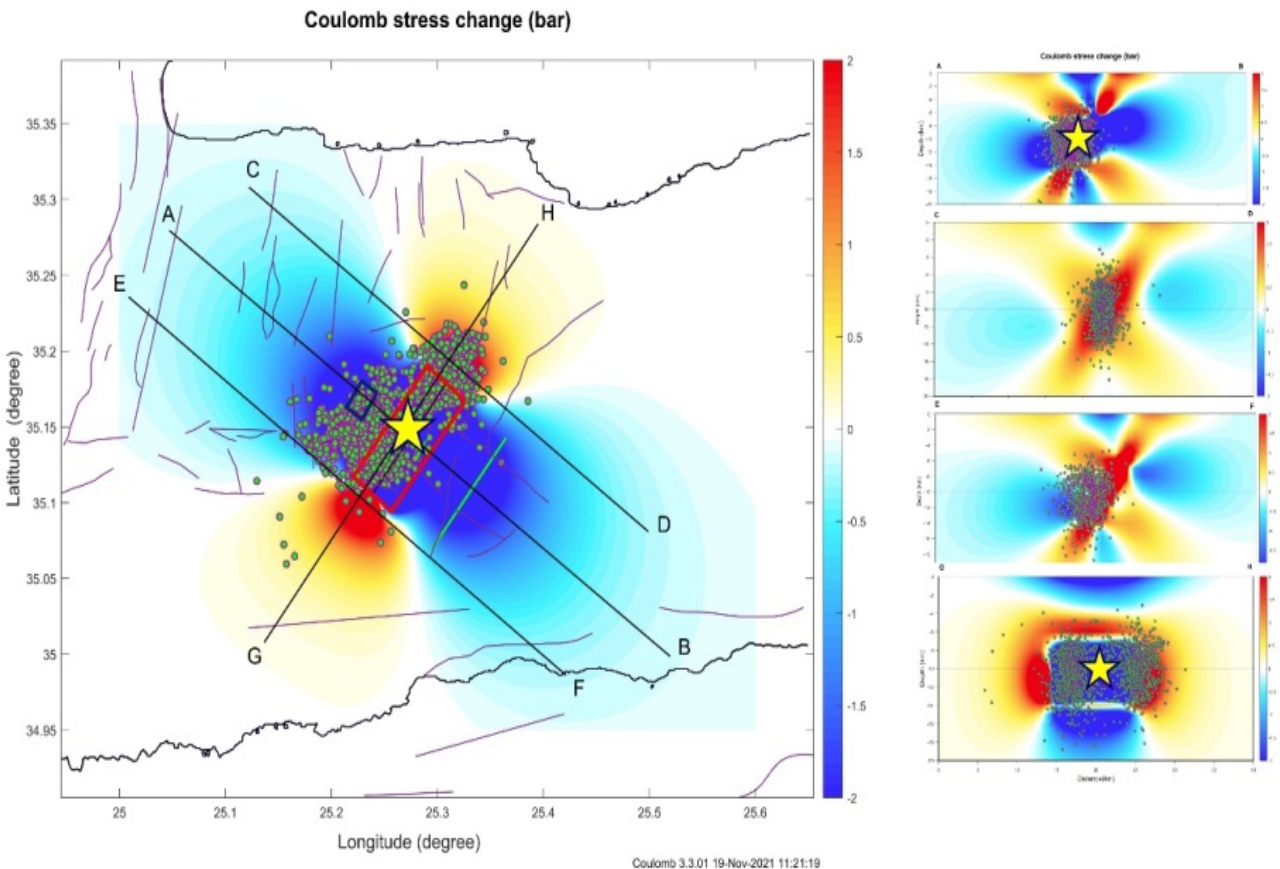
Figure 13. ( Left ) Coulomb stress changes distribution due to Mw = 6.0 event (yellow star) at centroid depth of 10.0 km. The red rectangle indicates the fault model for the kinematics of Mw = 6.0, while the blue one is the projection of the fault model of Mw = 4.9 events (listed in Table 3). ( Right ) Coulomb stress changes along the vertical cross-sections A-B, C-D, E-F, and the parallel cross-section G-H (from up to down). The green circles are the relocated hypocenters of the aftershocks which occurred after the Mw = 6.0 main shock. The green lines show the surface projections of the two fault models.